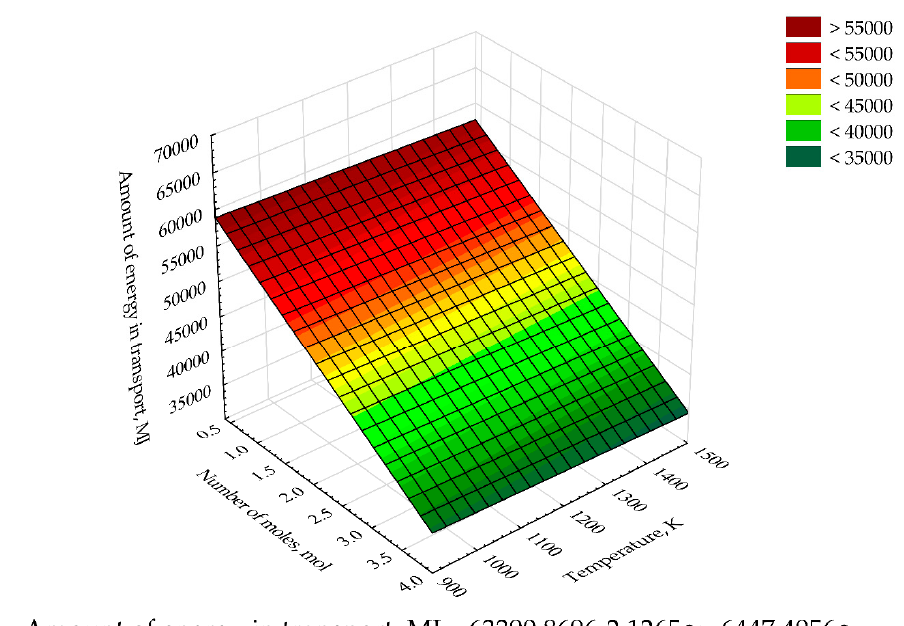
Figure 21. Energy content in the transport of syngas in the pressure vessels with a capacity of 14,960 m 3 at 200 bar at 293 K as a function of the number of moles of the gasification agent (x) and the temperature (y) of the gasification process using H 2 .